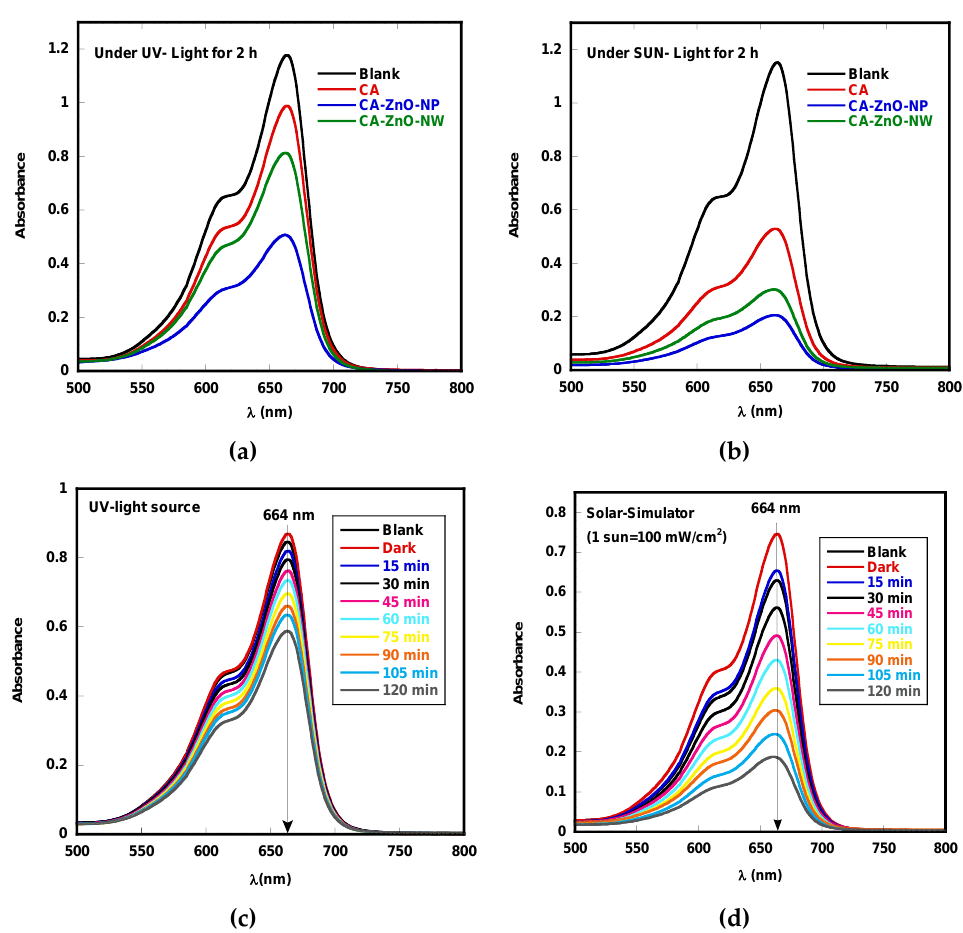
Figure 7. Photocatalytic degradation of MB by pristine CA, CA-ZnO-NP, and CA-ZnO-NW mem- branes, each after ( a ) UV-light irradiaton and ( b ) sunlight irradiation for 2 h; MB degradation in the CA-ZnO-NP membrane under ( c ) UV-light irradiation and d ) sunlight irradiation every 15 min.